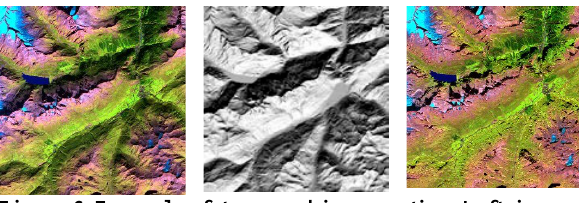
Figure 6 Example of topographic correction. Left image: without topographic correction; Middle: slope image derived from a DEM; Right: with topographic